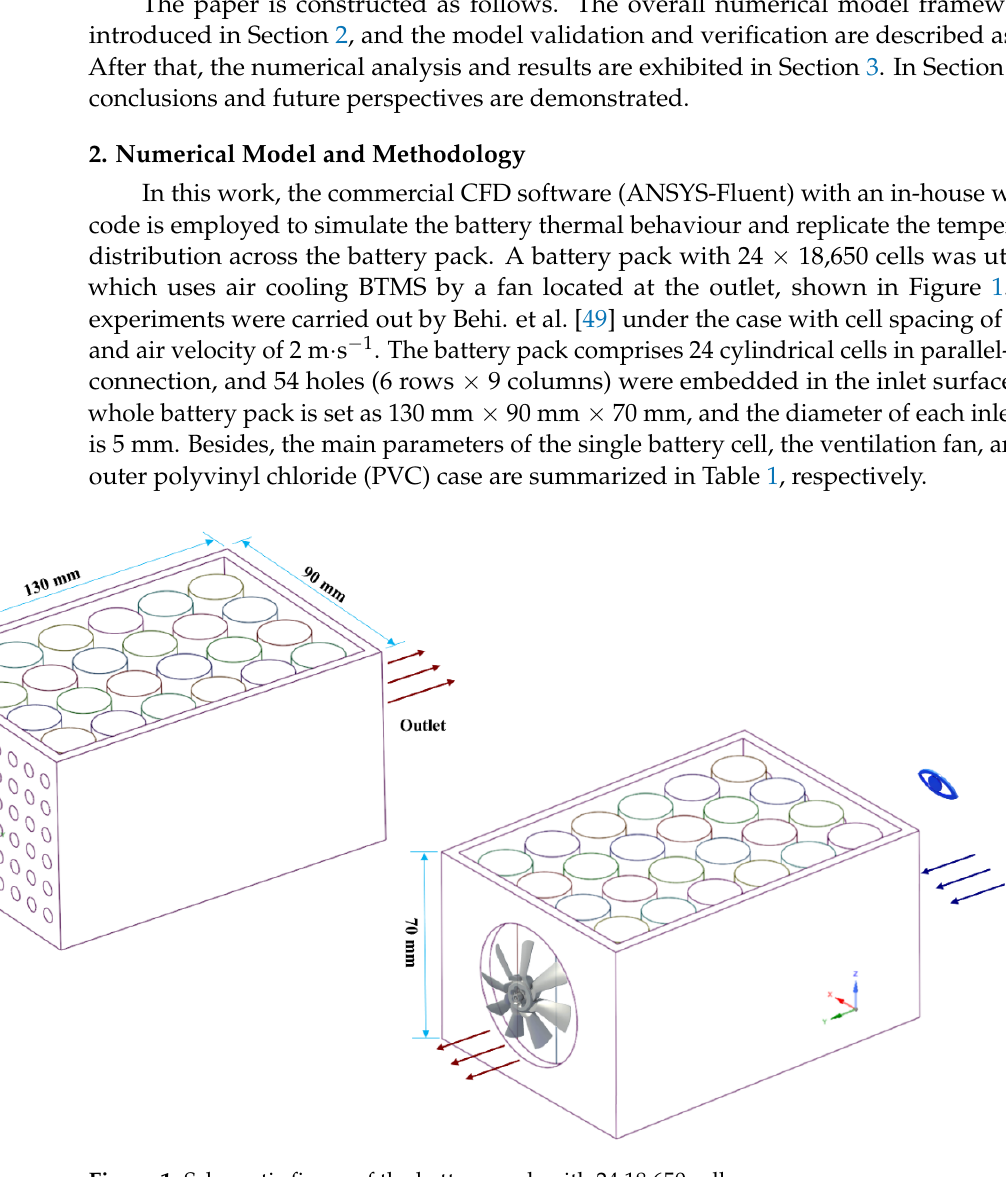
Figure 1. Schematic figure of the battery pack with 24 18,650 cells.